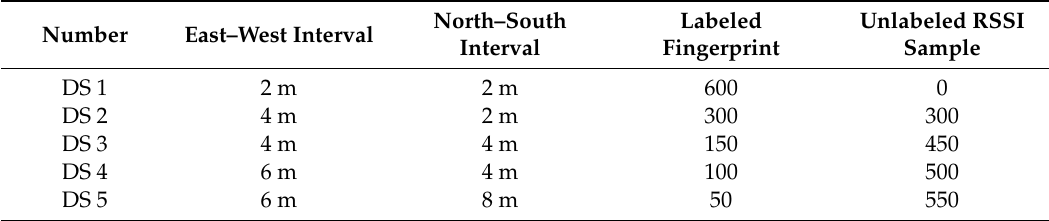
Table 3. The radio map construction scheme in the Library area.